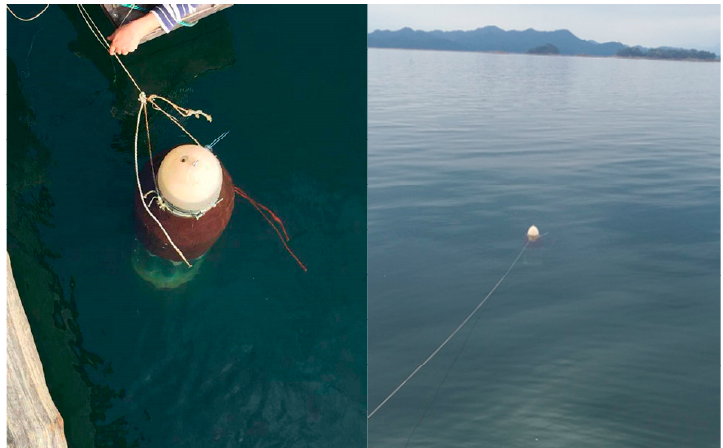
Figure 7. The lake test site.